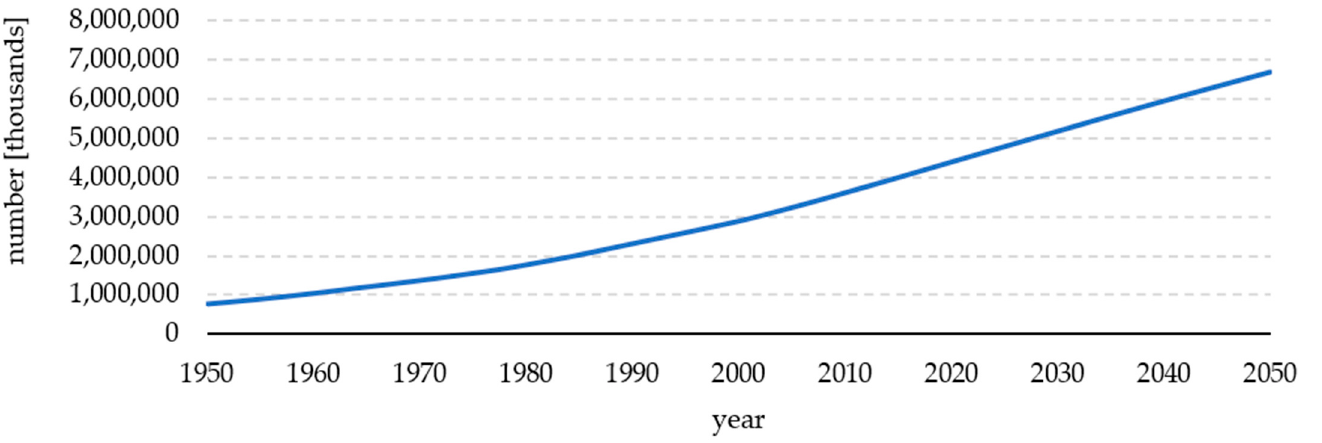
total urban population by another 2.5 billion people by 2050 compared to 2018 (Figure 2) [1]. [1].